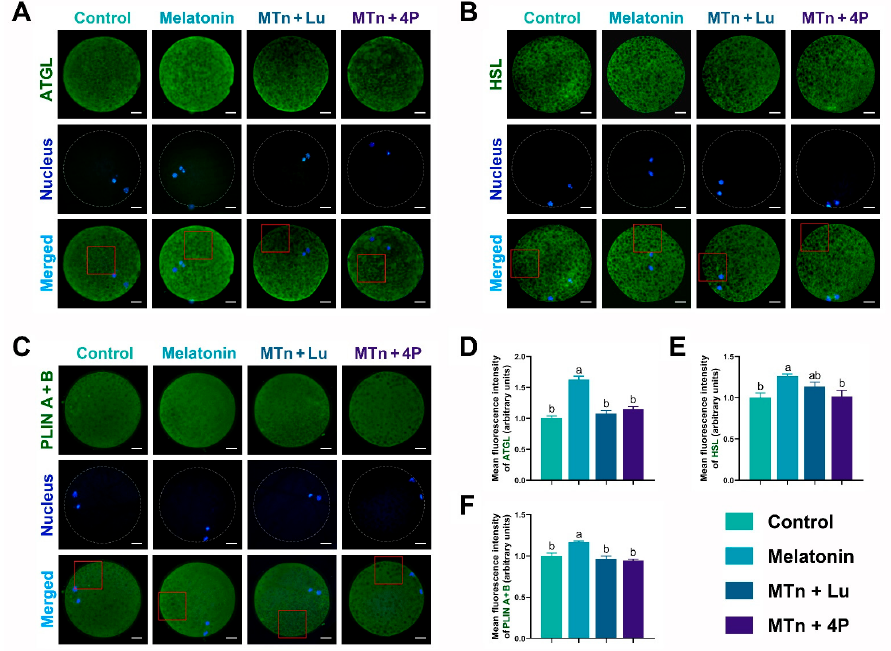
Figure 6. Expression of lipolysis-related proteins in the porcine oocyte. ( A , D ) ATGL, ( B , E ) HSL and ( C , F ) PLIN A + B. Melatonin/MTn, 10 − 9 mol/L melatonin; Luzindole/Lu, 10 − 9 mol/L Luzindole; 4P-PDOT/4P, 10 − 9 mol/L 4P-PDOT. Scale bar = 25 µ m. Different letters denote significant difference ( p <